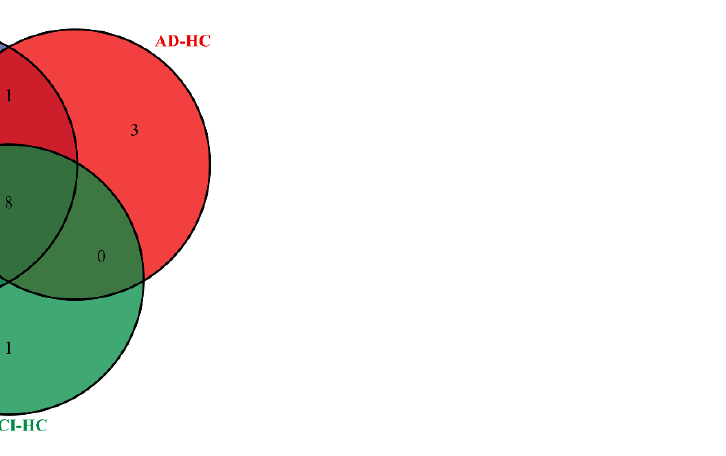
Figure 6. The distribution of pathways with the corrected p -value < 0.001 in the AD-HC group, AD-EMCI group and EMCI-HC group.